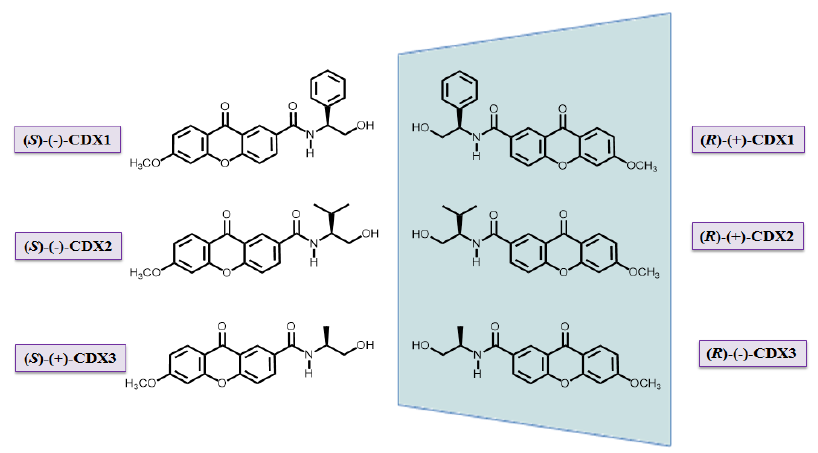
Figure 1. Structures of the enantiomers of CDXs 1 – 3 .